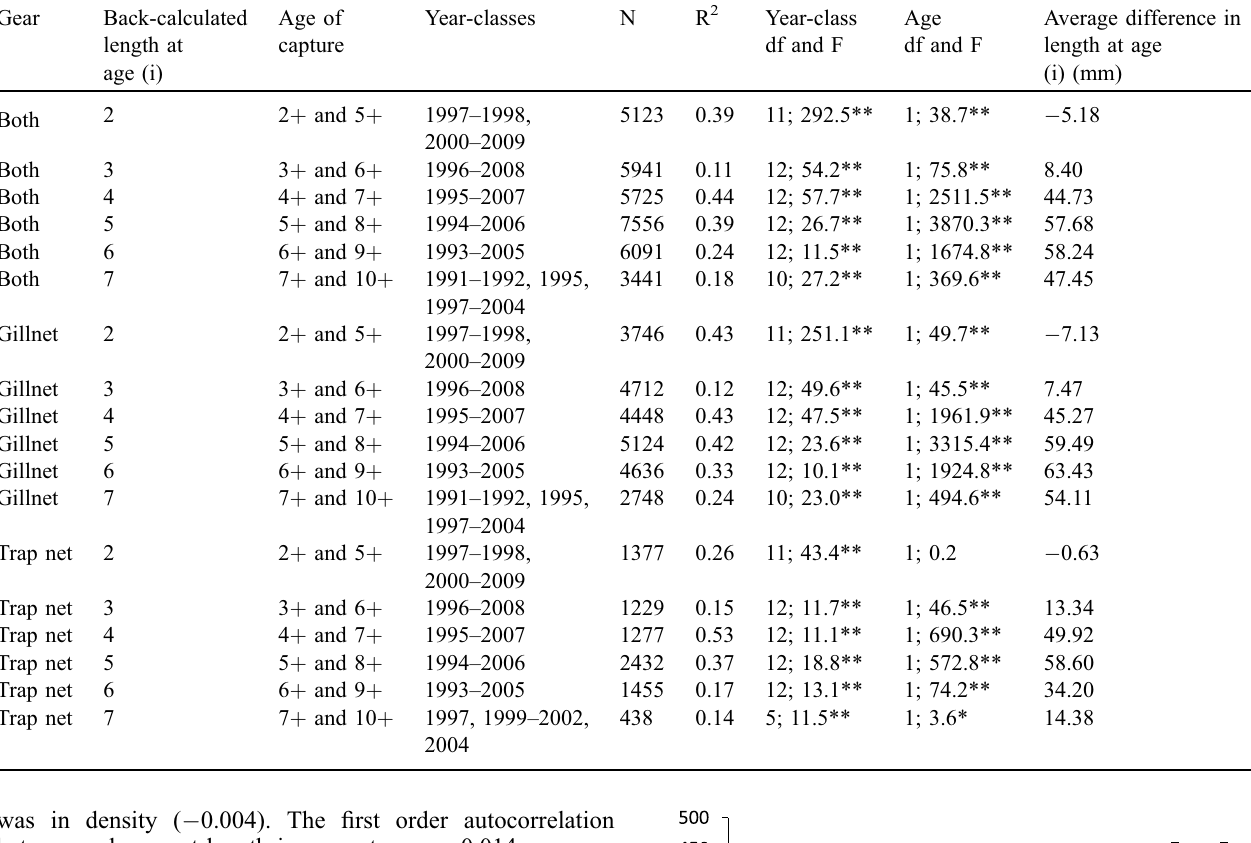
Table 3. ANOVA statistics and average differences in mean back-calculated lengths (mm) at age i between pikeperch caught at age i or i þ 3. R 2 is the adjusted R squared; * signi fi cance P < 0.05; ** P < 0.01.